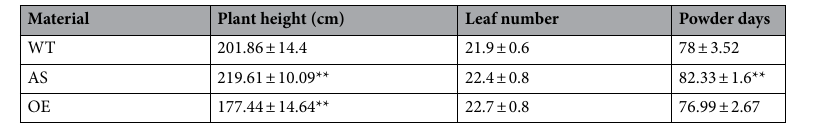
Table 2. Agronomic traits of maize plants. Note: indicate by the t-test analysis, ‘*’: P < 0.05; ‘**’: P <